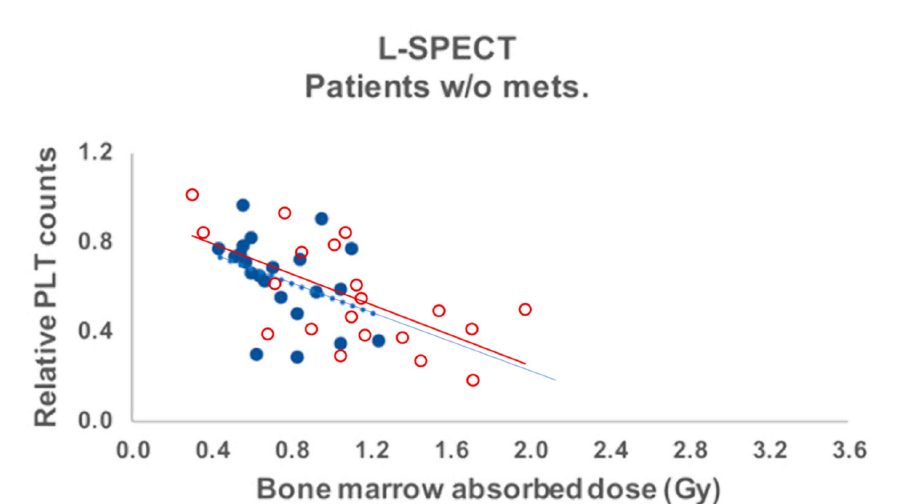
Figure 4. Blue solid circles: relative platelet counts decrease at nadir as a function of the red marrow in 177 Lu-DOTATATE therapy (Reprinted with permission from Ref. [29]. Copyright 2019 P Bernhardt). Red empty circles: decrease observed in the 90 Y-DOTATOC trial using 86 Y-DOTATOC PET-based dosimetry added by the authors [24]. Both trendlines are very